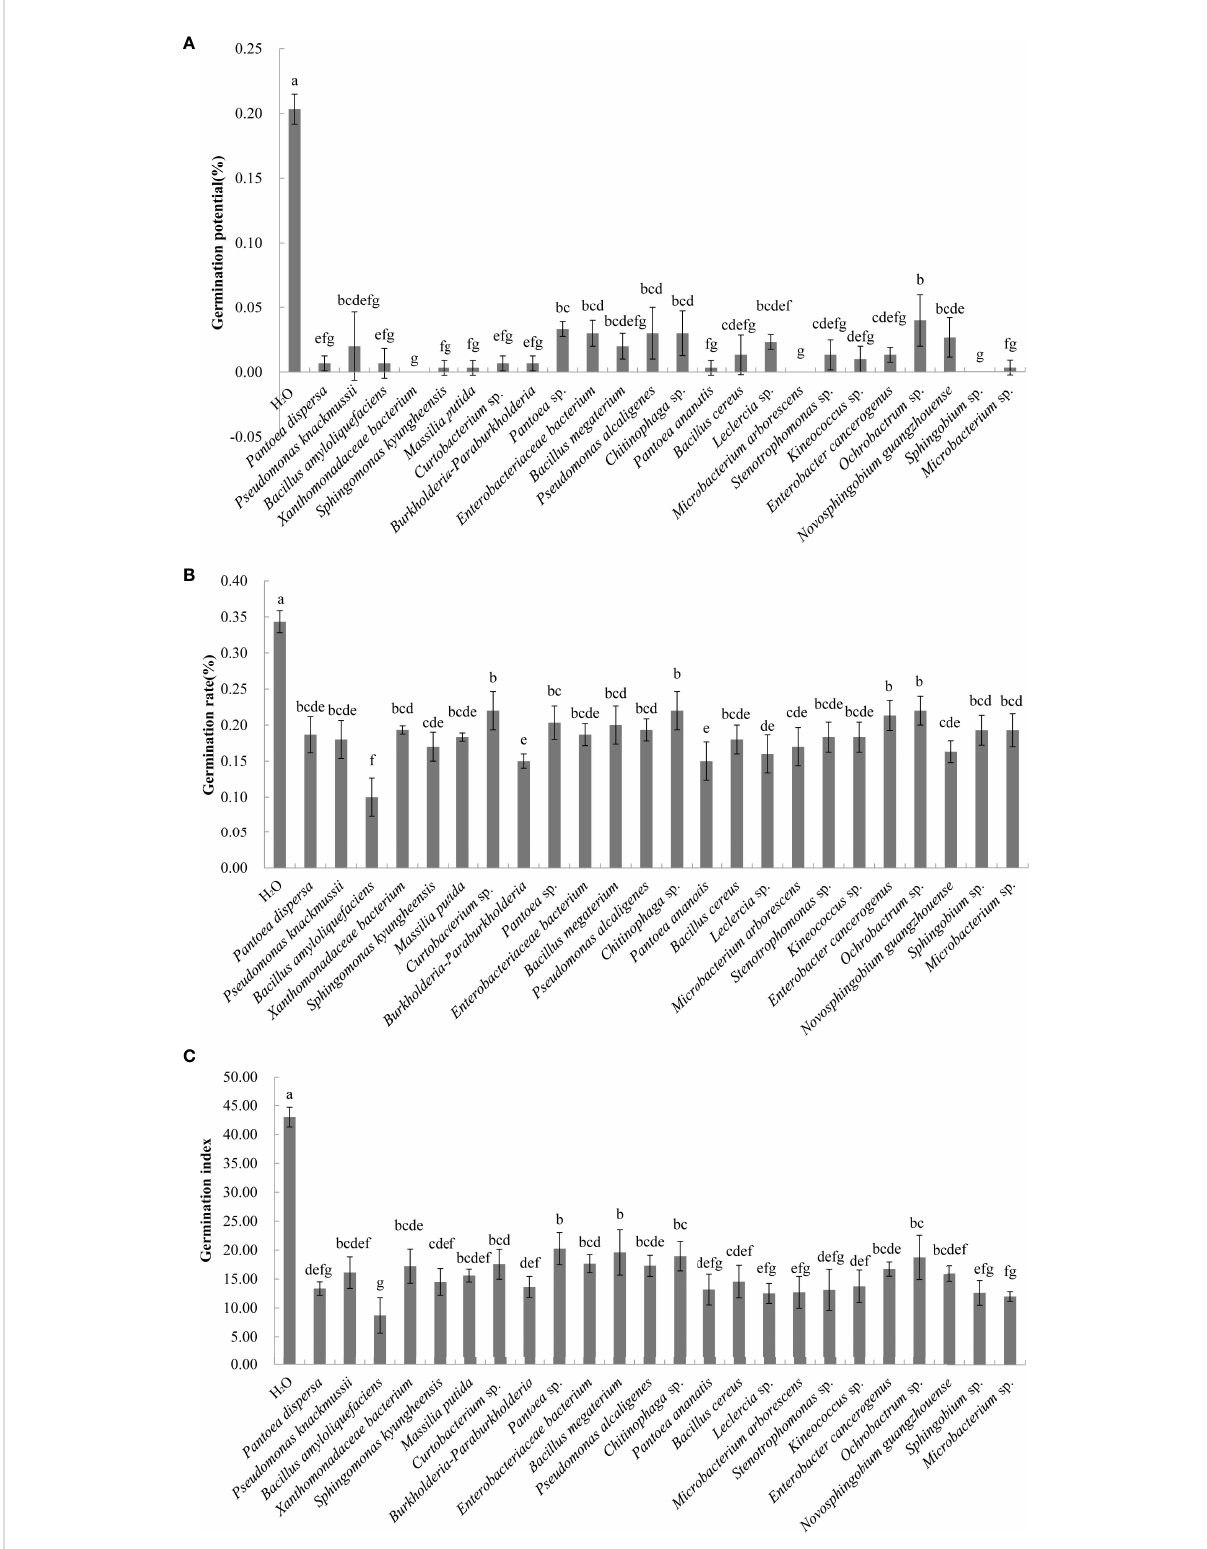
FIGURE 3 Effect of the bacterial isolates on the germination rate of C. equisetifolia seeds. Values marked with different letters are signi fi cantly different at p<0.05. (A) germination potential; (B) germination rate; and (C) germination